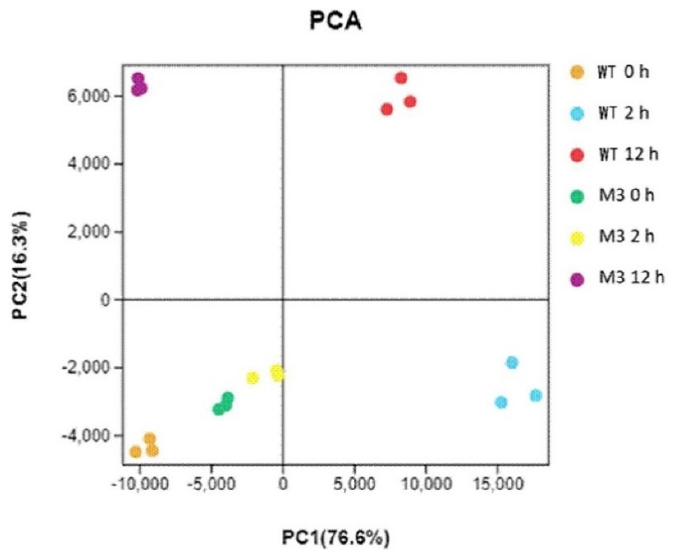
Figure 2. Principal component analysis (PCA) for all RNA-seq samples. WT CK, WT 2 h, and WT 12 h represents WT samples before low-temperature stress treatment and obtained at 2 h and 12 h after low-temperature stress treatment, respectively. M3 CK, M3 2 h, and M3 12 h represent M3 plant samples before low-temperature stress treatment and obtained at 2 h and 12 h after low-temperature stress treatment, respectively.